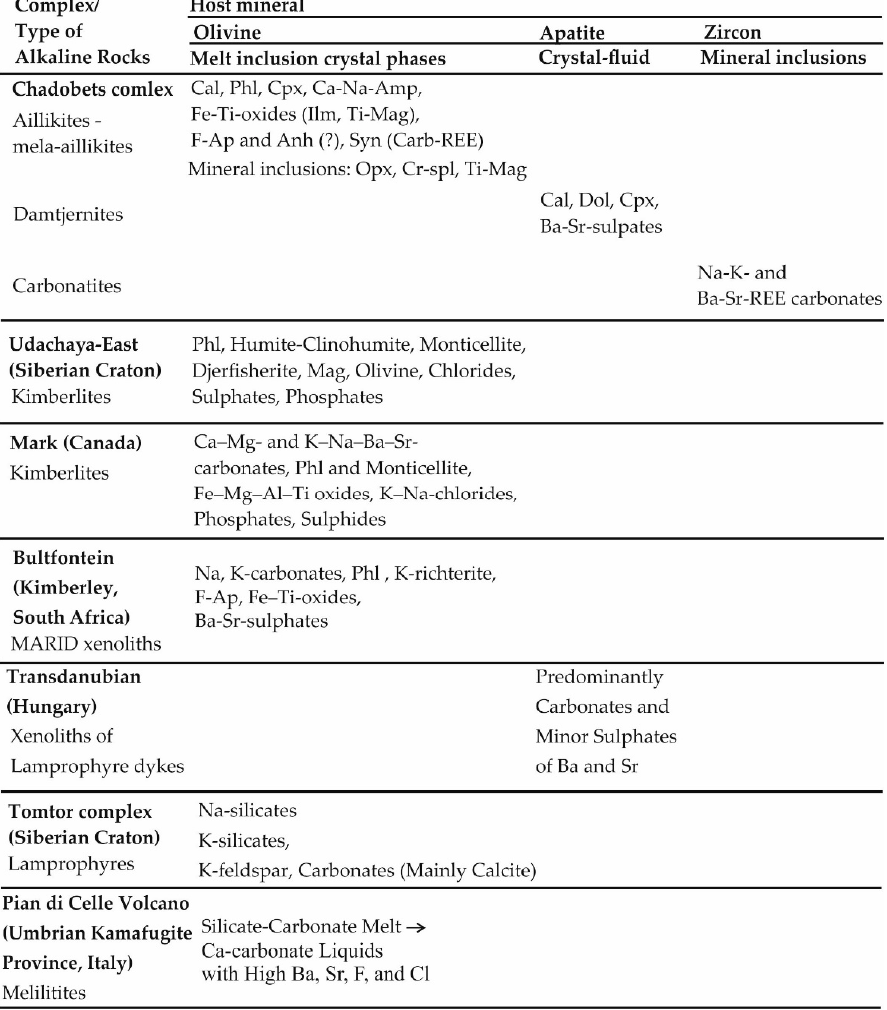
Figure 13. Melt and mineral inclusions composition of UMLs and carbonatites [8] of the Chadobets complex; kimberlites of the Udachnaya-East pipe (Siberian Craton) [53,61–64], the Mark kimberlites (Canada) [65], and MARID xenoliths of the Bultfontein kimberlites (Kimberley, South Africa) [66]; melt inclusion compositions of the mantle xenoliths of lamprophyre dykes from the Transdanubian (Central Range, Hungary) [67], the lamprophyres of the Tomtor alkaline-carbonatite complex (Siberian Craton, Anabar Shield) [68], and the melilitites of the Pian di Celle Volcano (Umbrian Kamafugite Province, Italy) [69].